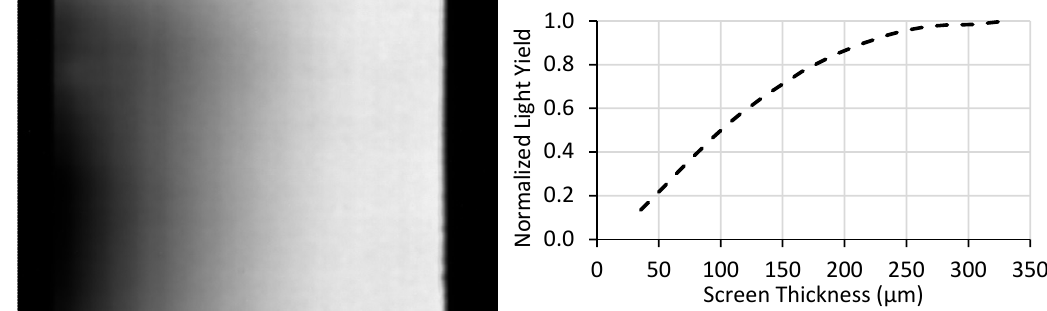
Figure 6. (Left) Light output image from a 6 LiF:ZnS test-screen. (Right) The resulting plot of light yield Figure 6. ( Left ) Light output image from a 6 LiF:ZnS test-screen. ( Right ) The resulting plot of light versus thickness determined using the pixelwise correlation method. yield versus thickness determined using the pixelwise correlation method.